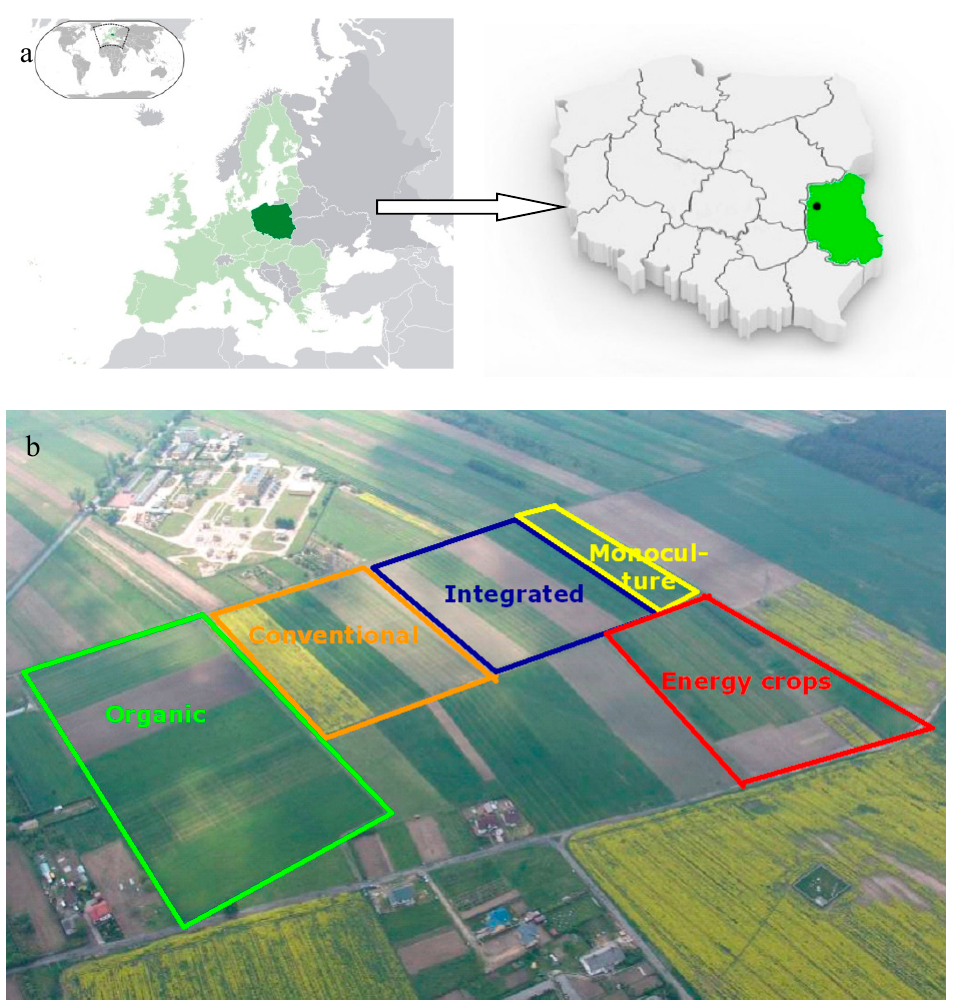
Figure 1. Location ( a ) and scheme ( b ) of experimental fields with energy crops and agricultural crops under different production systems.